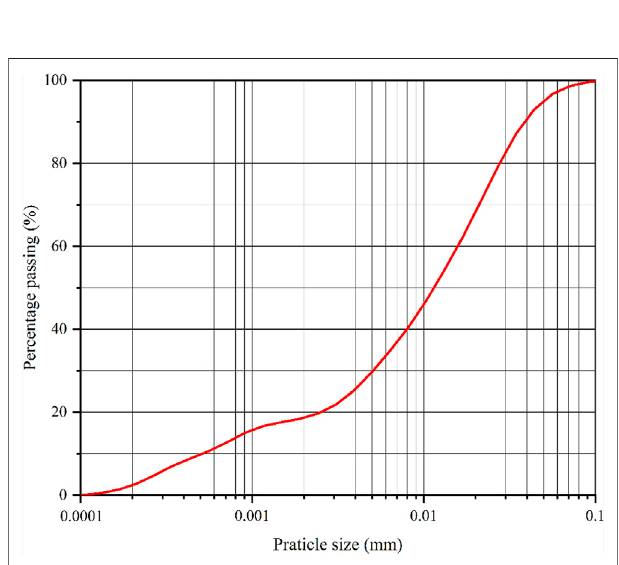
FIGURE 3 | Particle size distribution of dam